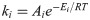
Random parameterization of a classical model to explain the gene expression data in Fig 1.(A) The classical model with negative feedback only (Goodwin model). Variables presented are mRNA concentration (M) and the concentration of a cytosolic protein (R) and nuclear protein (P) that downregulate the expression of this mRNA. (B) Distribution of period as reaction rates are increased. First, starting from the standard parameter set: n = 2, vs = 1.6, KI = 1, vm = 0.505, KM = 0.5, ks = 0.5, vd = 1.4, KD = 0.13, k1 = 0.5, and k2 = 0.6, we prepared 500 basic parameter sets for which parameters vs, vm, ks, vd, k1, and k2 ranged from one-half and to double the standard values. Second, using the 500 basic parameter sets, we constructed 100 additional parameter sets for each basic parameter set in which vs, vm, ks, vd, k1, and k2 were increased randomly 1.5- to 2.5-fold above the basic parameter set values. The average parameter increase was ~2-fold. Of 50,000 parameter sets, sustained oscillations were obtained using 20,680. We plotted the ratio (relative period), defined as the new period with increased reaction speed divided by the basic period with basic parameter sets. (C) Distribution of both the oscillatory mRNA amplitude (M, pink) and the geometric mean (green) of M, R, and P relative amplitudes plotted as a function of relative period when reaction rates are increased (20,680 parameter sets). (D) Two example time series (black and red) of mRNA (M) at “low (20°C)”, “medium (25°C)”, and “high (30°C)” temperature. Parameter values at low temperature are the values of the standard parameter set above. Parameter values at different temperatures are changed according to the Arrhenius equation of ki=Aie−Ei/RT, where Ei is activation energy. Activation energies (Ei) of vs, vm, ks, vd, k1, and k2 for period-maintained case (red) were 637, 328, 327, 663, 311, and 601, respectively. Corresponding values for period-shortening case (black) were 570, 594, 597, 615, 354, and 303, respectively, while the other parameters were fixed for the simplicity (see text). Equations were solved numerically using the Runge–Kutta method with Δt = 0.01.